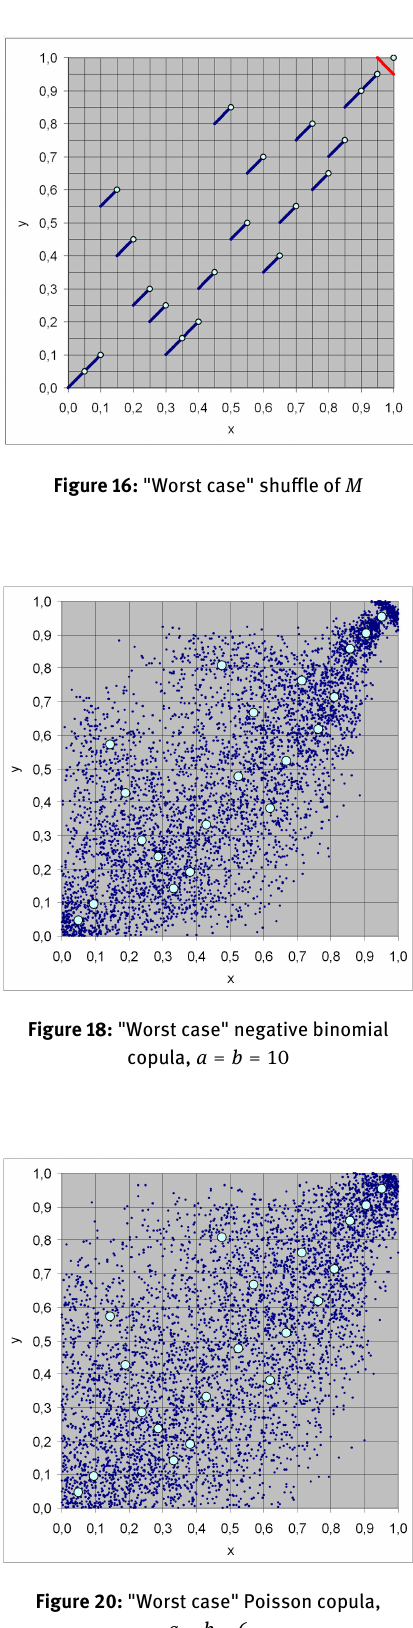
Figure 20: "Worst case" Poisson copula, a = b =